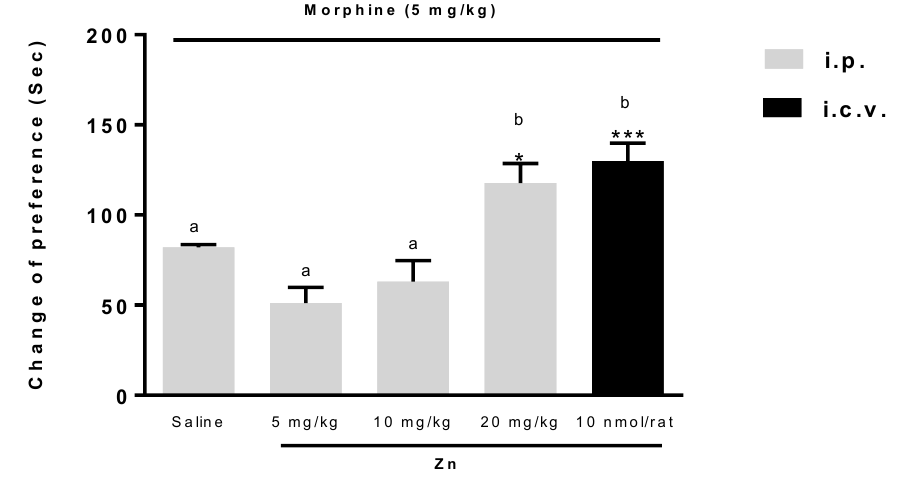
Figure 3. Effect of Zn on the expression of morphine-induced CPP. Zn was given i.p. (5, 10 and 20 mg/kg) and i.c.v. (10 nmol/rat) separately in the post-conditioning sections. Each point represents the mean± SEM of six rats. * and ***Presents significant between saline (10 ml/kg, i.p.) group at p < 0.05 and p < 0.001, respectively. Different letters indicate significant differences between groups (p<0.05) (Tukey’s post-hoc test). Zn=Zinc.